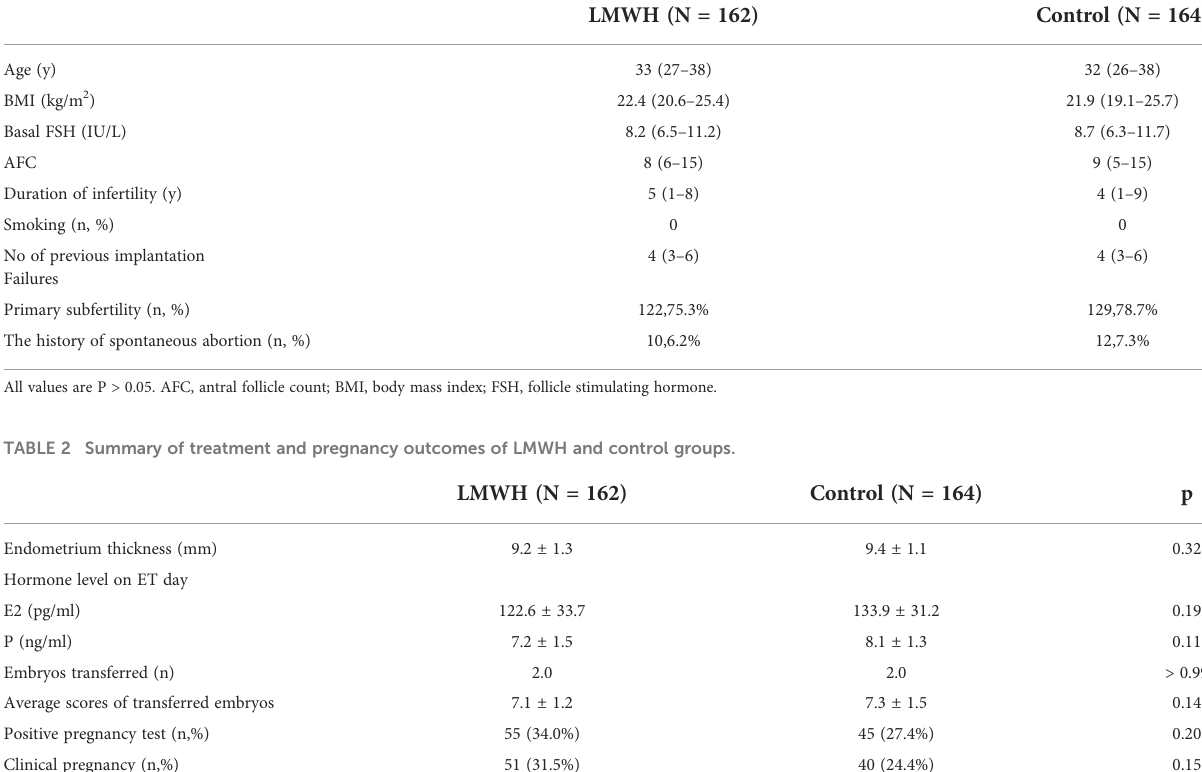
TABLE 1 Baseline and demographic characteristics of the participants.